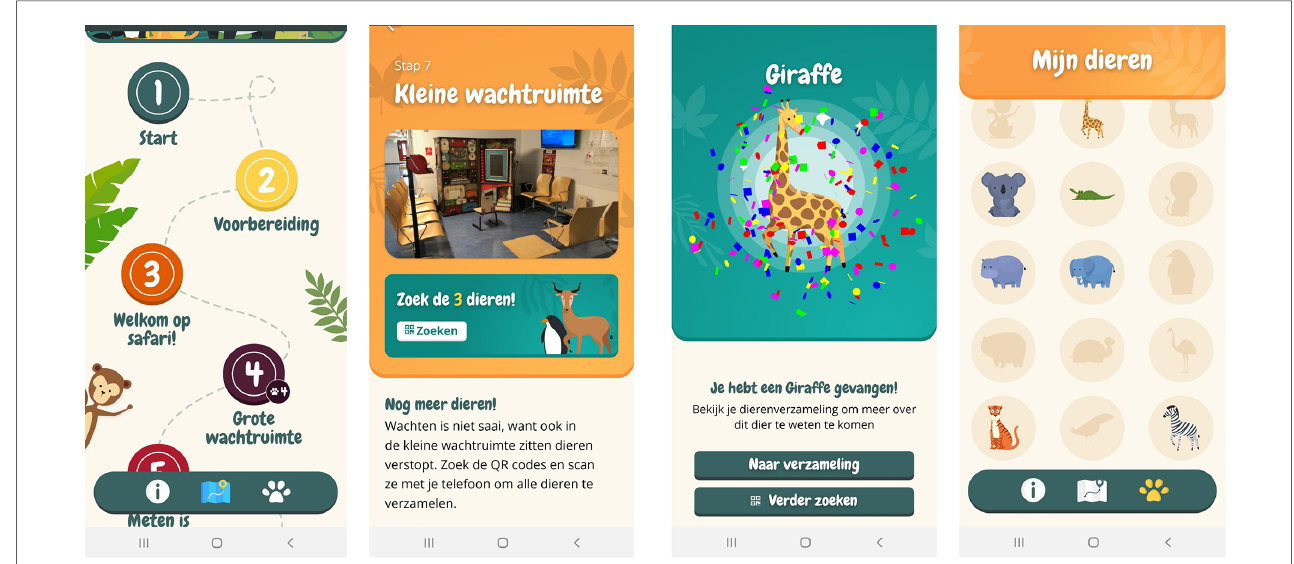
FIGURE 3 Visuals of the fi nal version of the hospital Hero app. From left to right: “ Journey map ” homescreen, waiting room step, new animal collected, animal collection